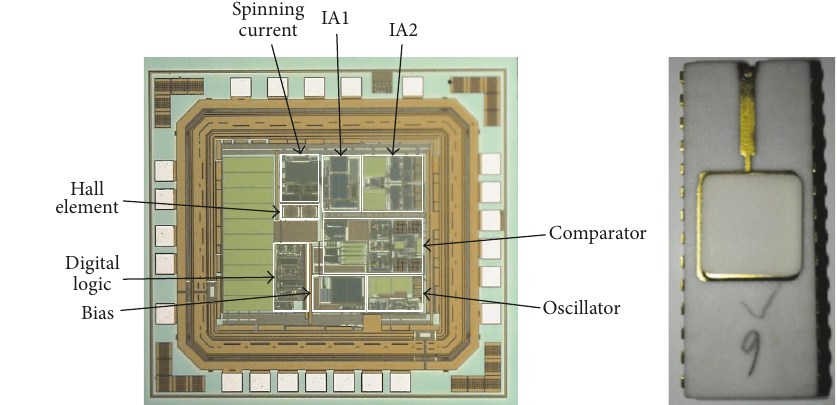
Figure 13: Photograph of the chip and packaging.